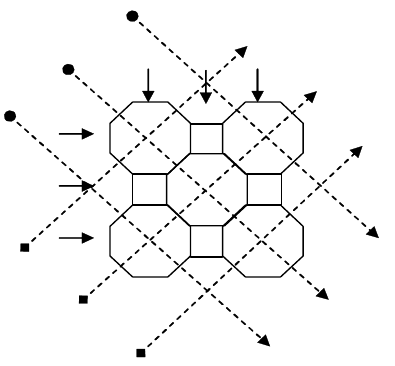
Figure 3. Four projections on 3 × 3